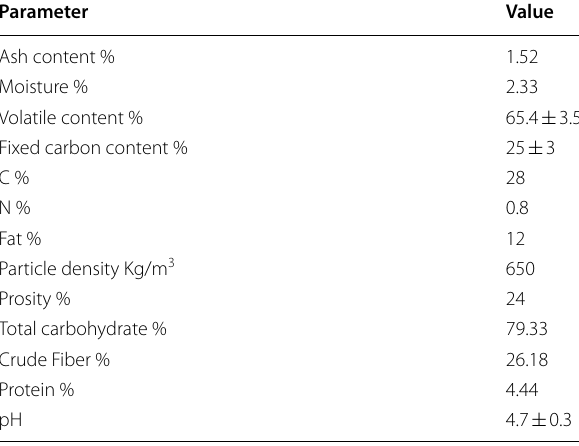
Table 3 Physico-chemical properties of date